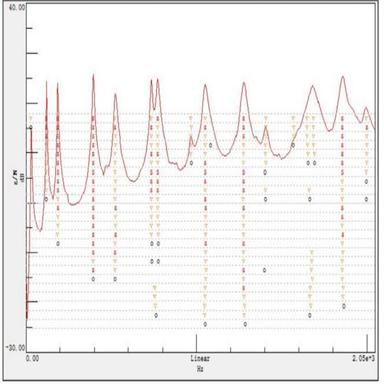
Typical FRF curve of the FFF 3D printing plate. ing structures are also the core of study.